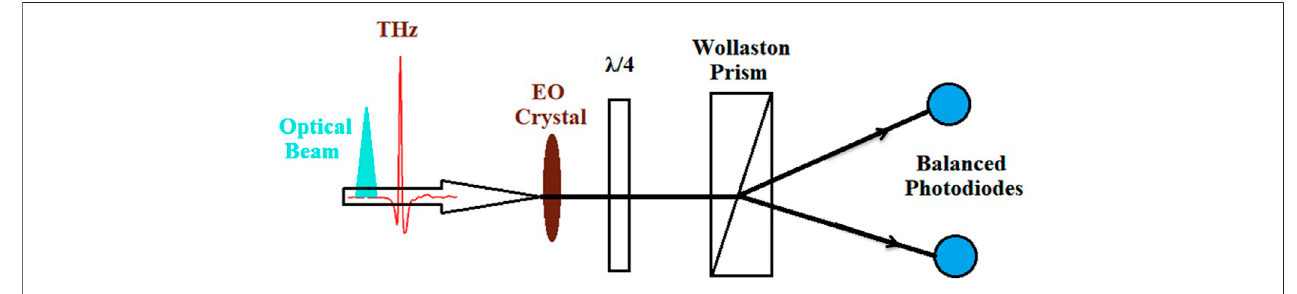
FIGURE 3 | The basic electro-optic sampling scheme with a balanced detection